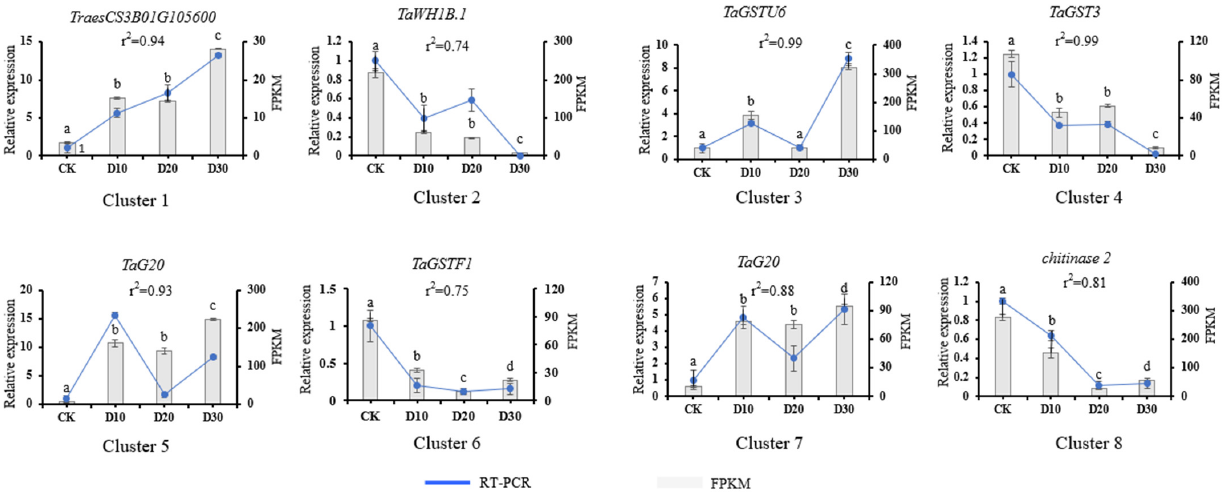
Figure 7. Validation of DEGs was performed using qRT-PCR. A total of eight genes were selected for validation. The x-axis indicates samples in di ff erent time spots. The left y-axis indicates relative gene expression levels detected by qRT-PCR. The right y-axis indicates FPKM value. Di ff erent le tt ers represent signi fi cant di ff erences between the two sets of data.